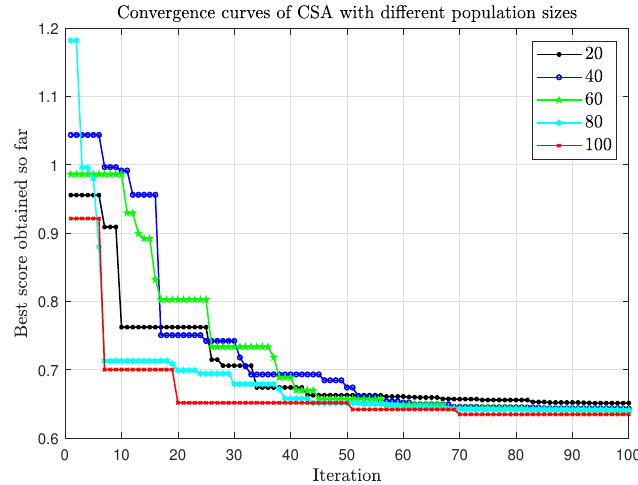
Figure 5. Convergence curves of CSA using various numbers of population